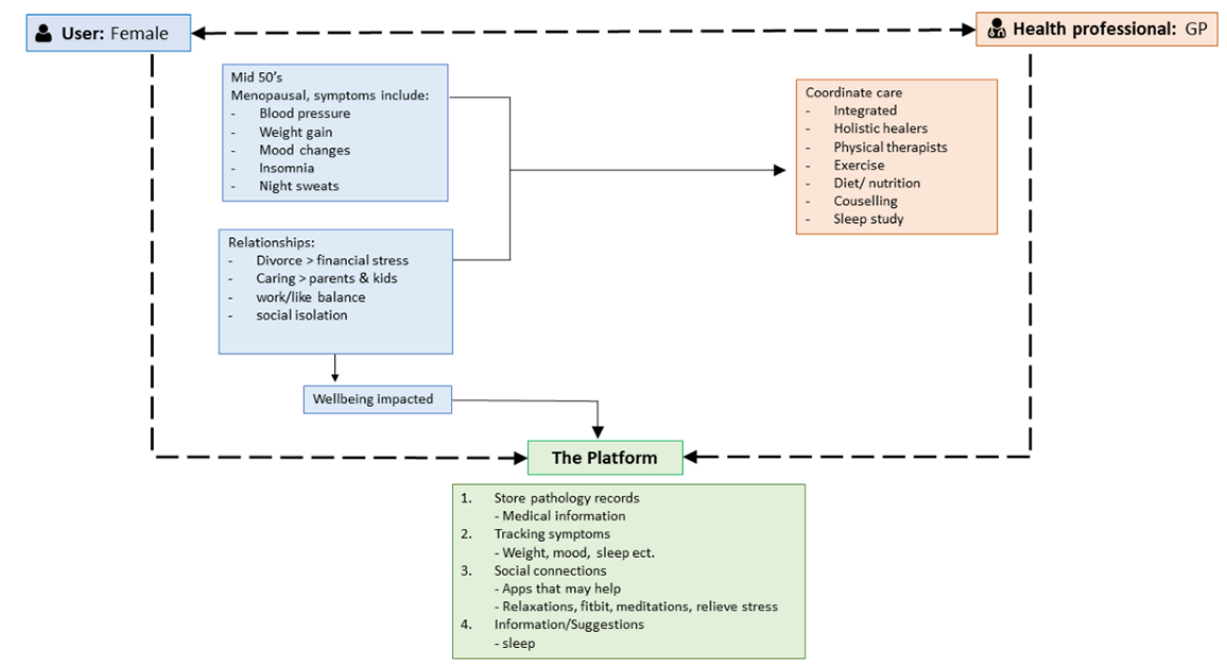
Figure 2. User journey demonstrating how a consumer might engage with the